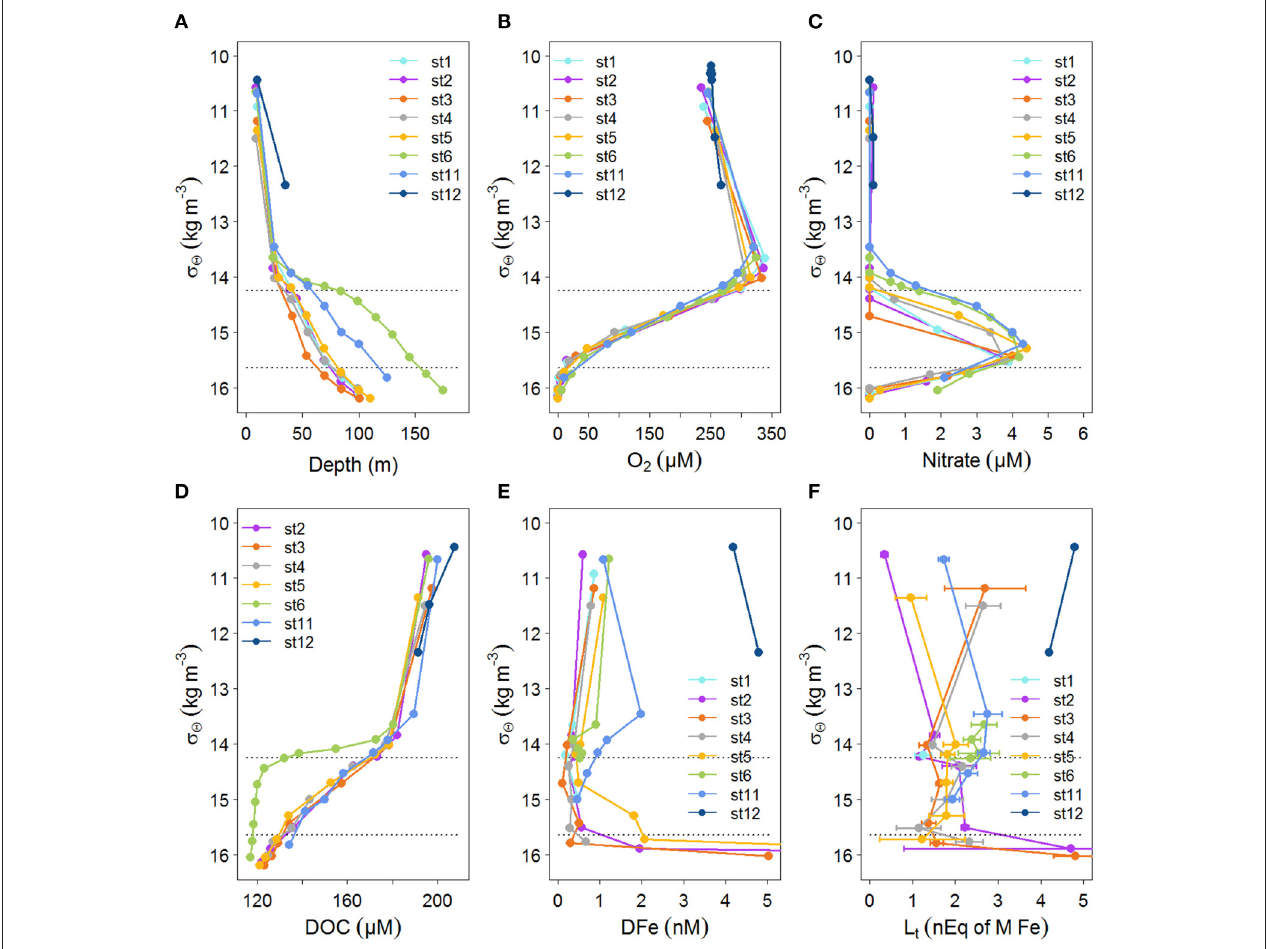
FIGURE 3 | Profiles of concentrations with density, σ 2 (kg m − 3 ), for the stations indicated in Figure 1. The profiles are as in Figure 2 with the exception of Figure 2A , instead of fluorescence, here the relation with depth is given. If available data is given until σ 2 = 16.2kg m − 3 . The upper boundary of the oxycline and its lower boundary (i.e., the OL-suboxic interface) at σ 2 = 14.25kg m − 3 and 15.64kg m − 3 , respectively, are indicated by dotted lines. (A) Depth (m). (B) Oxygen concentration ( µ M) from calibrated CTD sensor data. (C) Nitrate ( µ M). (D) DOC ( µ M) from Margolin et al. (2016). (E) Dissolved Fe (DFe, in nM), standard errors fall within the symbols (see Table 1 ). DFe at stations 2 and 5 at 100m are outside the scale, DFe increased from 84m to 100m from 1.95 to 27.6 at station 2 and from 2.06 to 13.4 at station 5. (F) Fe-binding dissolved organic ligands with standard errors of the fitting of the Langmuir isotherm ([L t ] in nEq of M